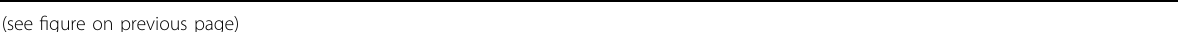
(see fi gure on previous page) Fig. 3 Activation of mitophagy induces apoptosis in HSCs. a Mitochondrial DNA (mtDNA) measured by PicoGreen staining in LX2 cells; scale bar, 10 μ m. b Representative western blots of TOM20 with GAPDH serving as the internal reference. Bar graph represents the mean ± SEM. * P < 0.05 vs. the indicated groups. c TUNEL staining of LX2 cells from the indicated groups; scale bar, 25 μ m. Bar graph represents the mean ± SEM. * P < 0.05 vs. the indicated groups. d Annexin V-FITC/PI double-staining and fl ow cytometry analysis of LX2 cells. Bar graph represents the mean ± SEM. ** P < 0.01